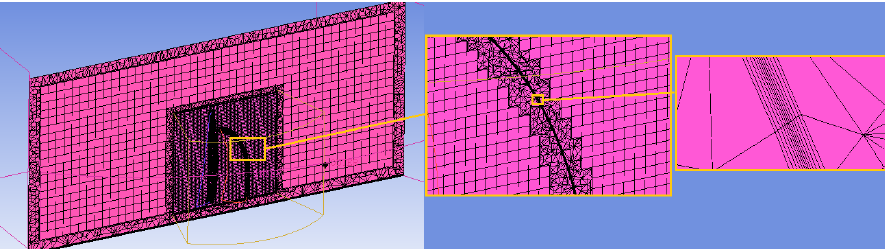
Figure 4. CFD meshed domain and enlarged views of the mesh around the sail.